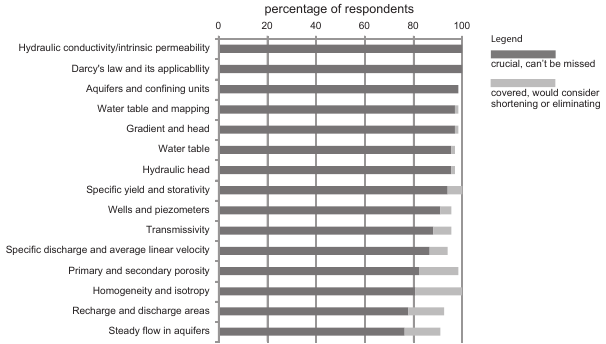
Fig. 3. The top 15 most important topics for an undergraduate hy- drogeology course according to a survey conducted in 2005 among academic hydrogeologists ( n = 68). A graphic compilation of all topics in the survey can be found in Fig. S1 in the